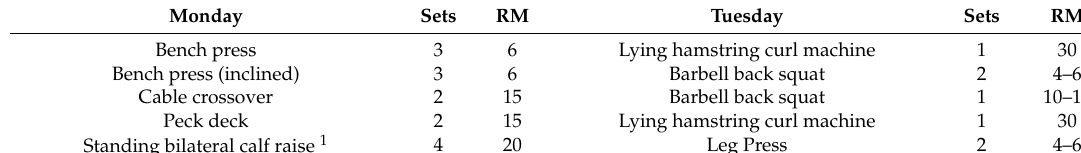
Table 3. Resistance training sessions carried out weekly for 11